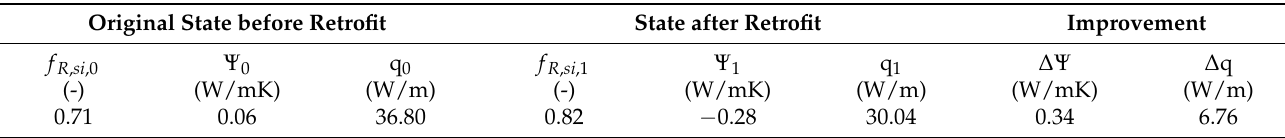
Table A27. Quantifiable results of the thermal bridge retrofit of a roof ridge (ThermCad thermal bridge simulation calculation).